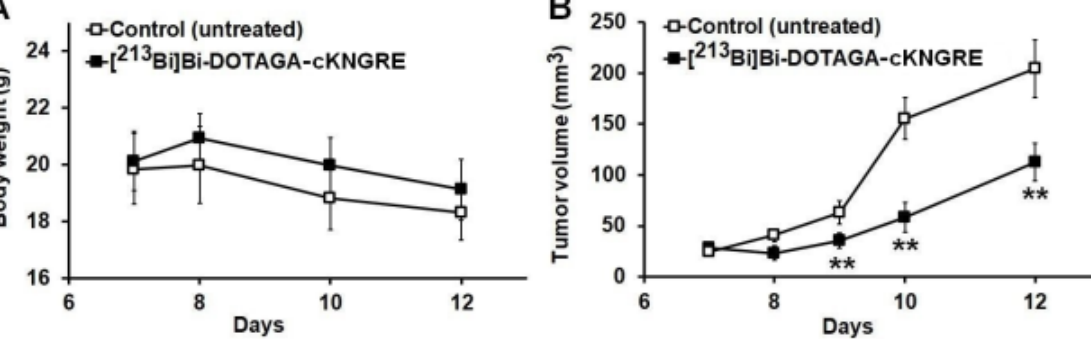
Figure 3. Impact of [ 213 Bi]Bi-DOTAGA-cKNGRE treatment on the body weight (grams/g) ( A ) and the tumour growth (mm 3 ) ( B ) changes of HT1080 tumour-bearing experimental mice. Treatment administration began 7 days after the subcutaneous injection of HT1080 fibrosarcoma cancer cells at an average tumour volume of approximately 25 mm 3 . Significance level between the untreated control group (n = 5) and the [ 213 Bi]Bi-DOTAGA-cKNGRE treated group (n = 5) was p ≤ 0.01 (**) ( B ). 213 Bi: bismuth-213; DOTAGA: 1,4,7,10-tetrakis(carboxymethyl)-1,4,7,10-tetraazacyclododecane glutaric acid; cKNGRE: cyclic Lysine–Asparagine–Glycine–Arginine–Glutamic